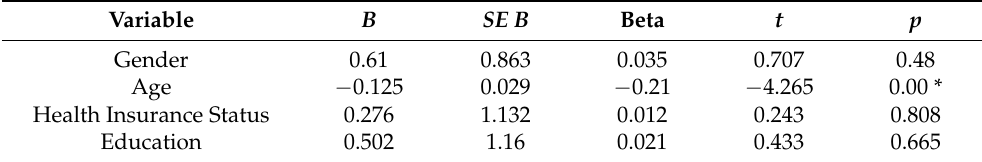
Table 2. Multiple Linear Regression Results for Complete Vaccination Prevalence.